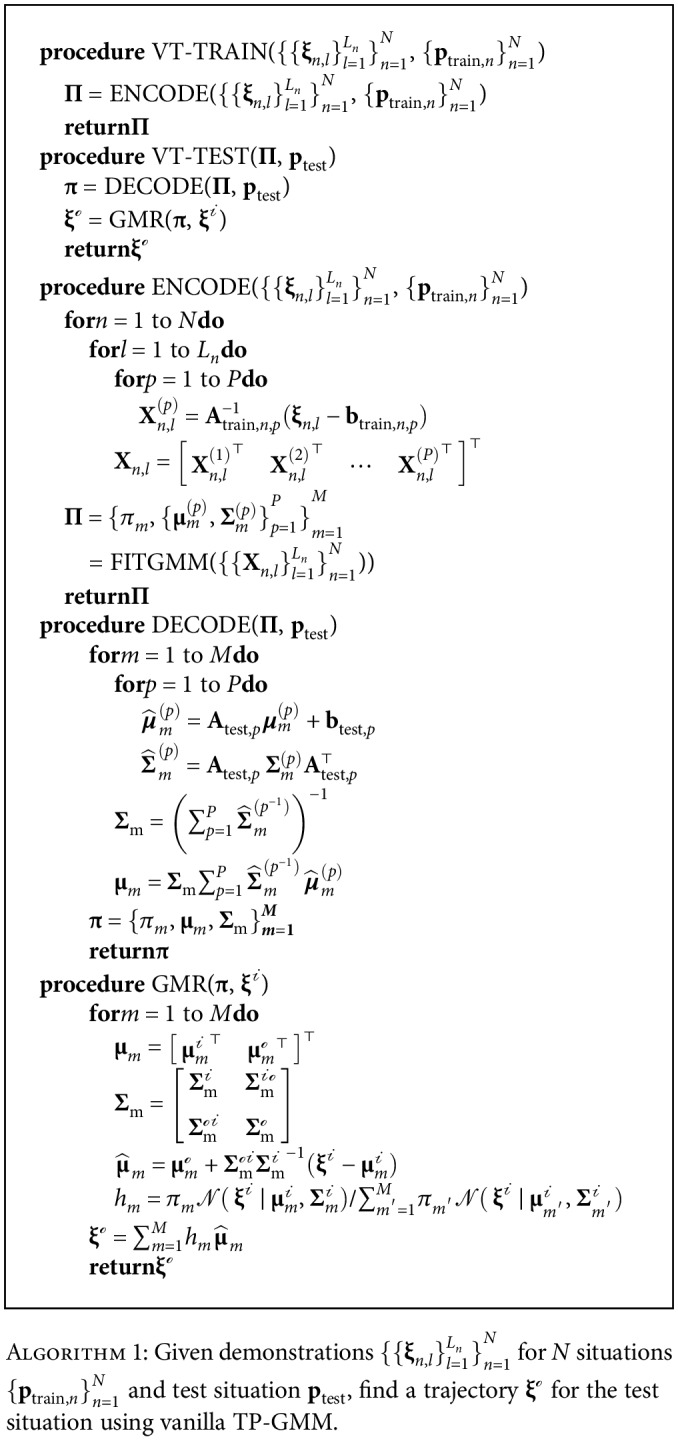
 Given demonstrations {{ξn,l}l=1Ln}n=1N for N situations {ptrain,n}n=1N and test situation ptest, find a trajectory ξℴ for the test situation using vanilla TP-GMM.